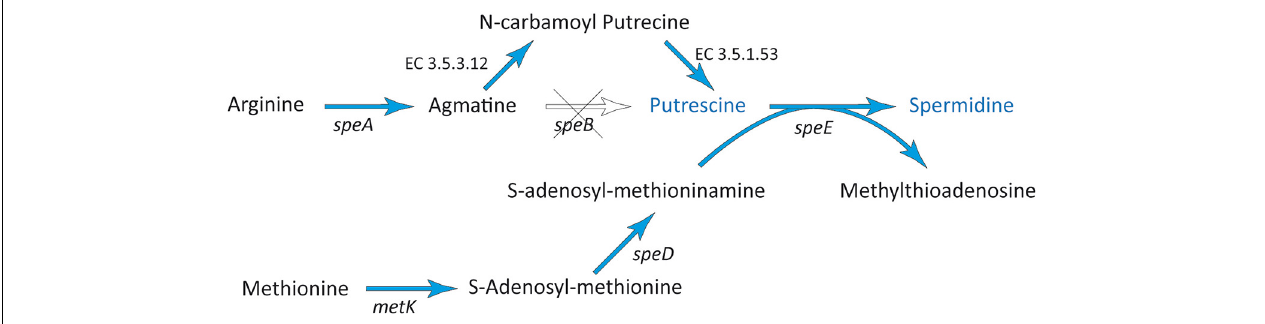
FIGURE 5 | Spermidine biosynthesis pathway found in Stenotrophomonas sp. 169. The scheme is based on Jelsbak et al. (2014) and Xie et al. (2014). Blue arrows indicate genes found in the genome of strain